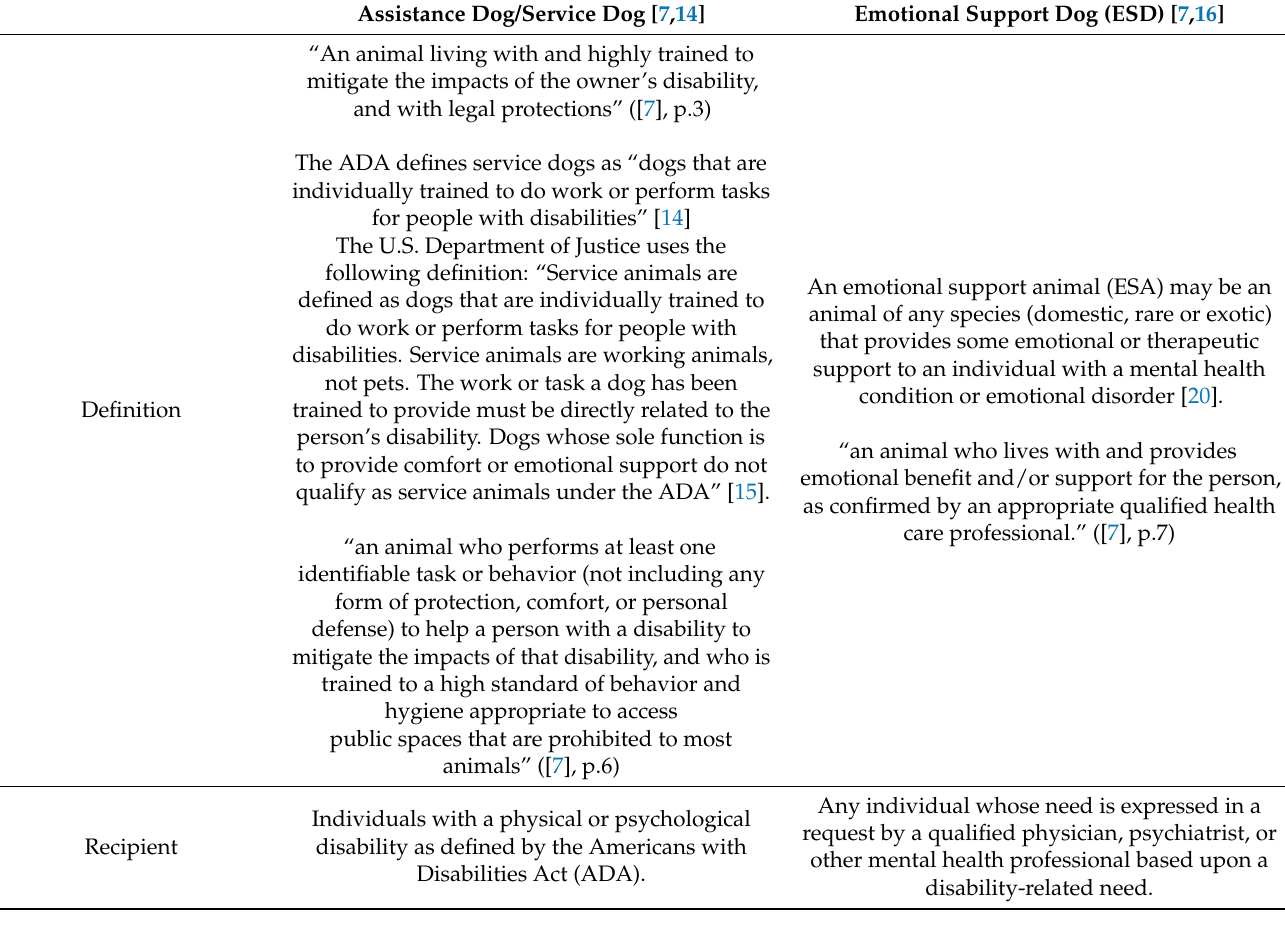
Table 1. Assistance Dogs and Emotional Support Dogs (ESD): Terminology, definitions, recipient. Assistance Dog/Service Dog